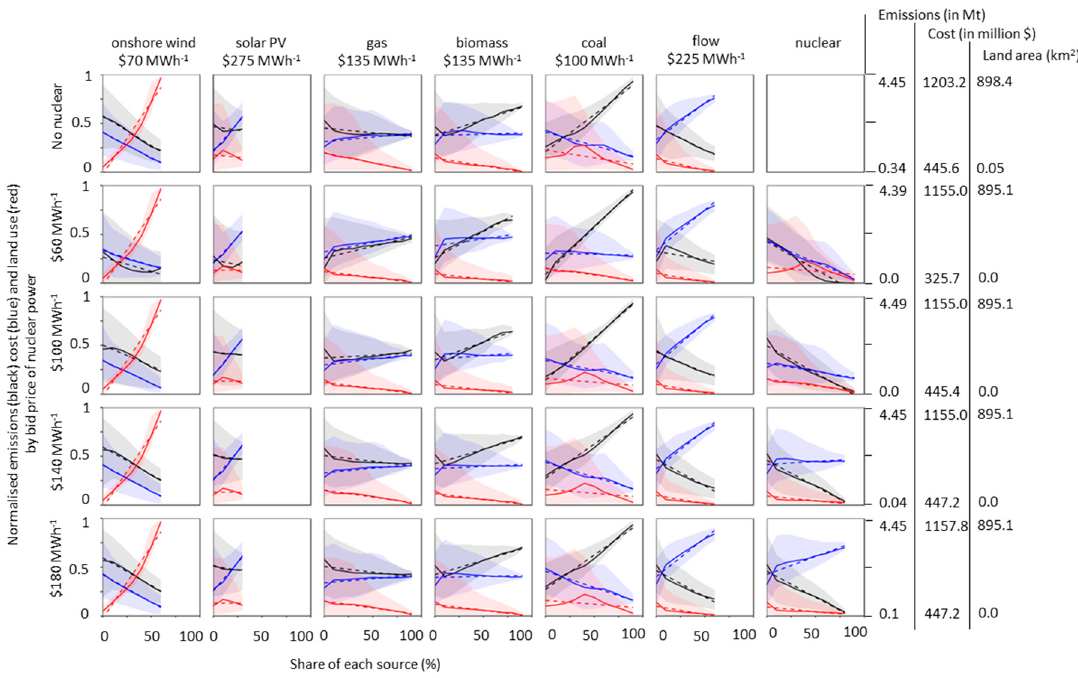
Figure 1. Jeju example: greenhouse-gas emissions (black) cost (blue) and land use (red) and its median for each section (continuous) based on incremental 5% changes in the share of each source of total annual generation, along with regression graphs (dotted) by the share of each electricity source. Each plot is redrawn from the same output to display the changes by share of each source.